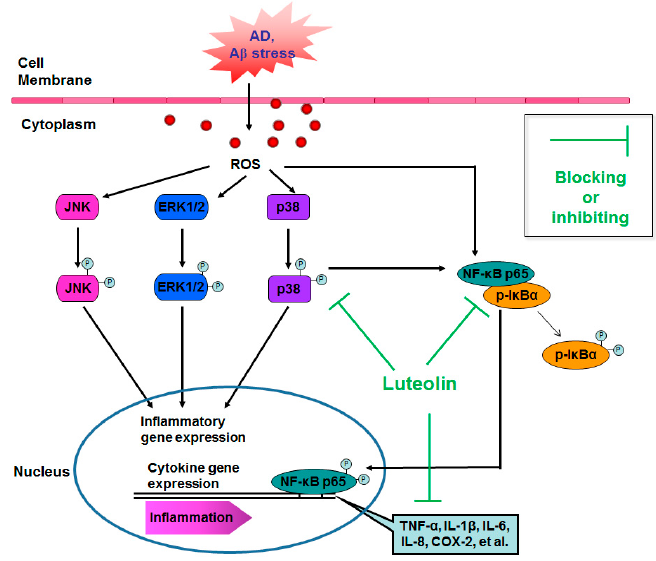
Figure 7. Possible mechanisms by which luteolin inhibits fibrillary β -amyloid 1–40 -induced inflammation in a BBB model. AD: Alzheimer’s disease; A β stress: amyloid- β peptide induced cellular stress; NF- κ B p65: nuclear factor κ B p65 subunit; p-I κ B α : phosphorylated inhibitory κ B α